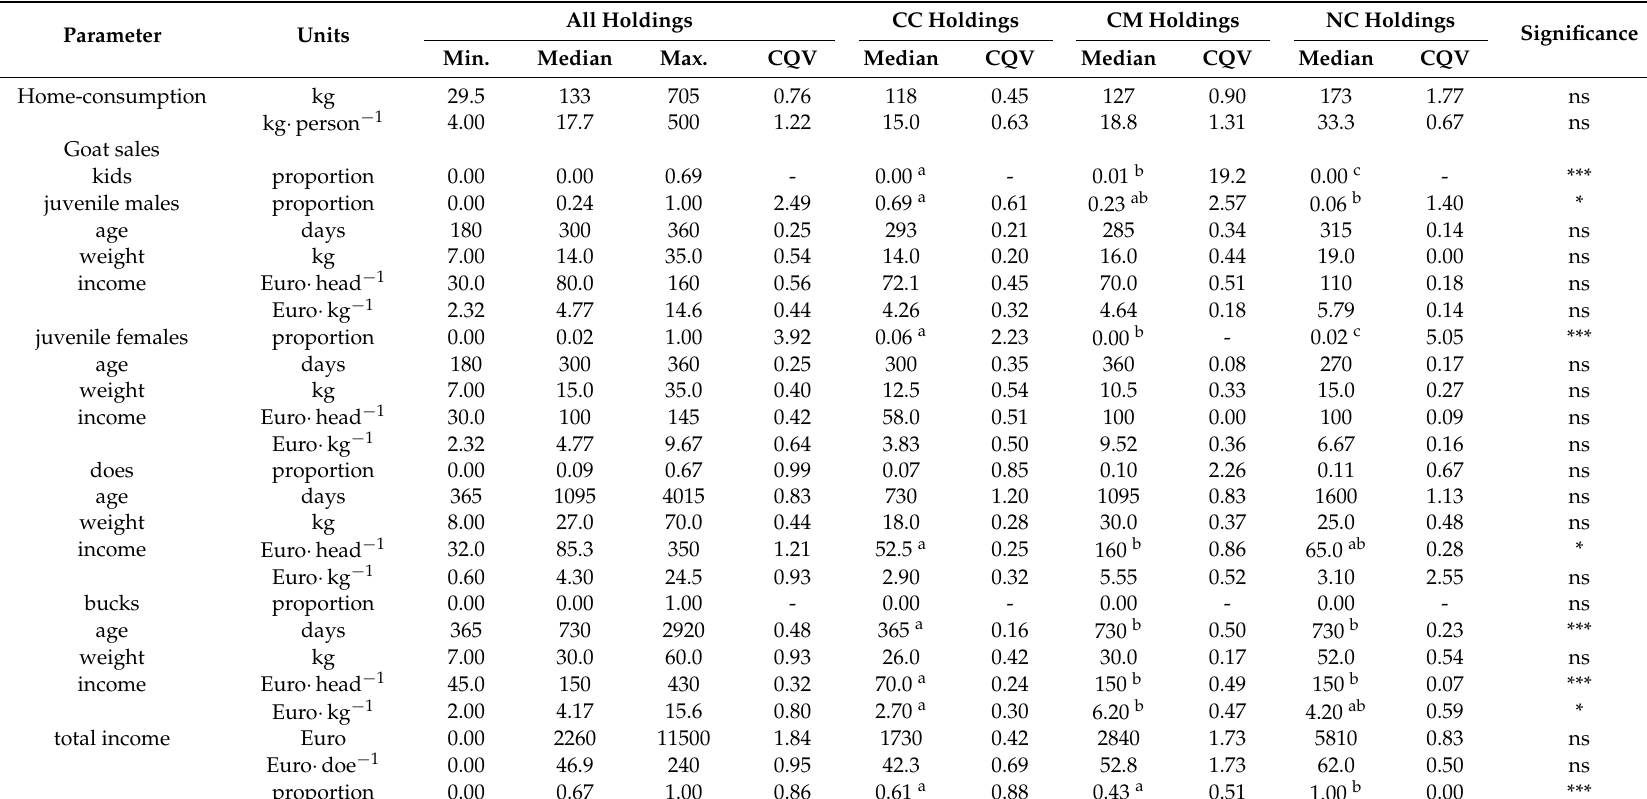
Table 6. Descriptive statistics for parameters relating to goat sales and meat consumption on ten goat holdings in the northern region of Morocco based on monthly data collections between September 2009 and August 2012. Holdings are classified by their dairy production status: commercial cheese (CC, n = 3), commercial milk (CM, n = 4) and non-commercial dairy (NC, n =